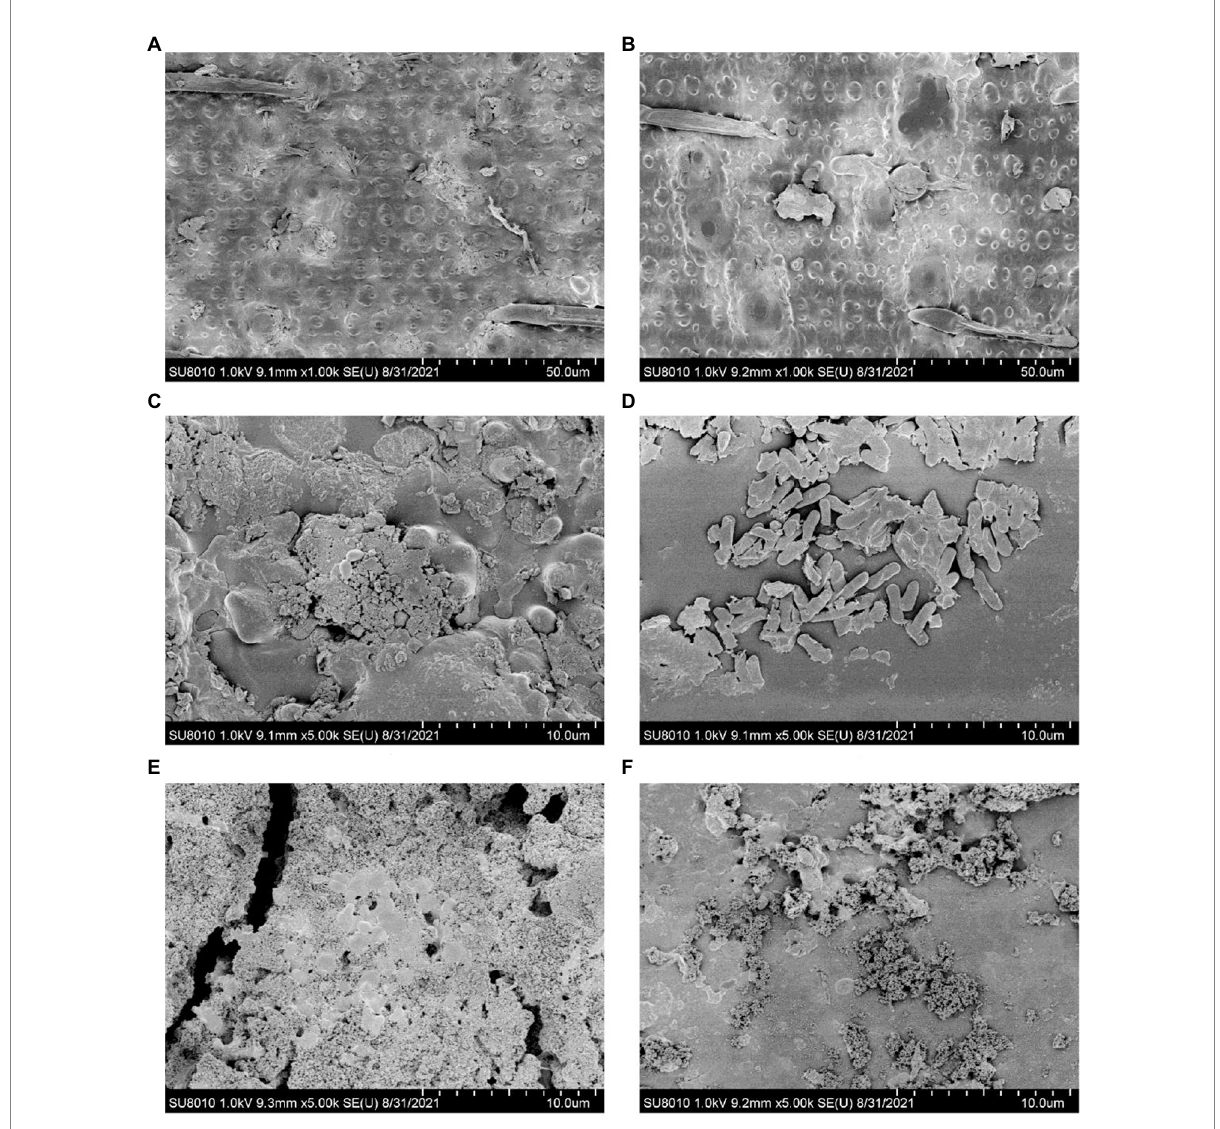
FIGURE 3 Scanning electron microscopy images of wild-type (A,C,E) and brittle culm 15 (B,D,F) mutant rice straws before and after 12- and 48-h in vitro ruminal